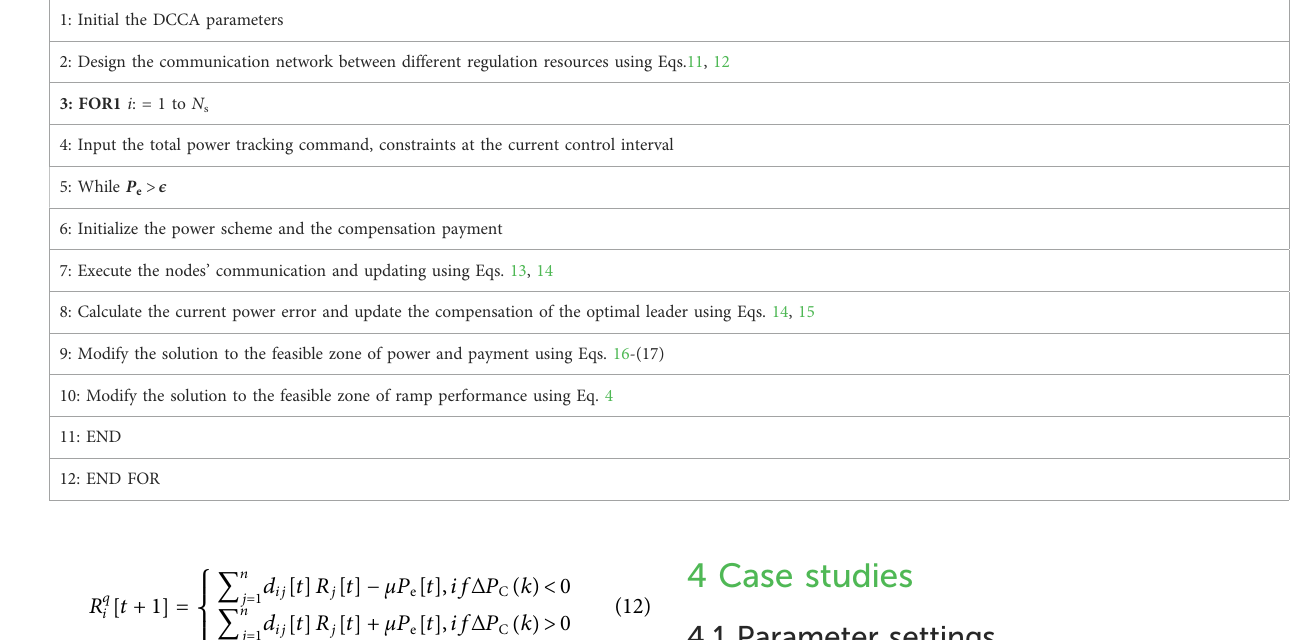
TABLE 1 xecution of DCCA for